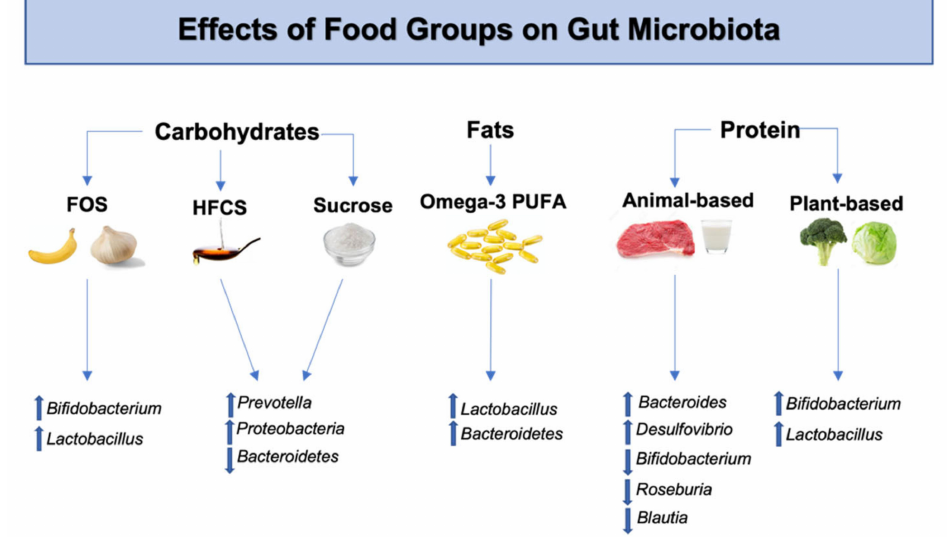
Figure 1. Effects of food groups on gut microbiota. FOS increase Bifidobacterium and Lactobacillus species in the gut [35]. HFCS and sucrose administration increases Prevotella and Proteobacteria while decreasing Bacteroidetes [36]. Omega-3 PUFA increase Lactobacillus and Bacteroidetes [37]. Animal- based proteins increase Bacteroides and Desulfovibrio while decreasing Bifidobacterium, Roseburia and Blautia [38,39]. Plant-based proteins increase Bifidobacterium and Lactobacillus [40]. Abbreviations: FOS, fructo-oligosaccharides; HFCS, high-fructose corn syrup; PUFA, poly-unsaturated fatty